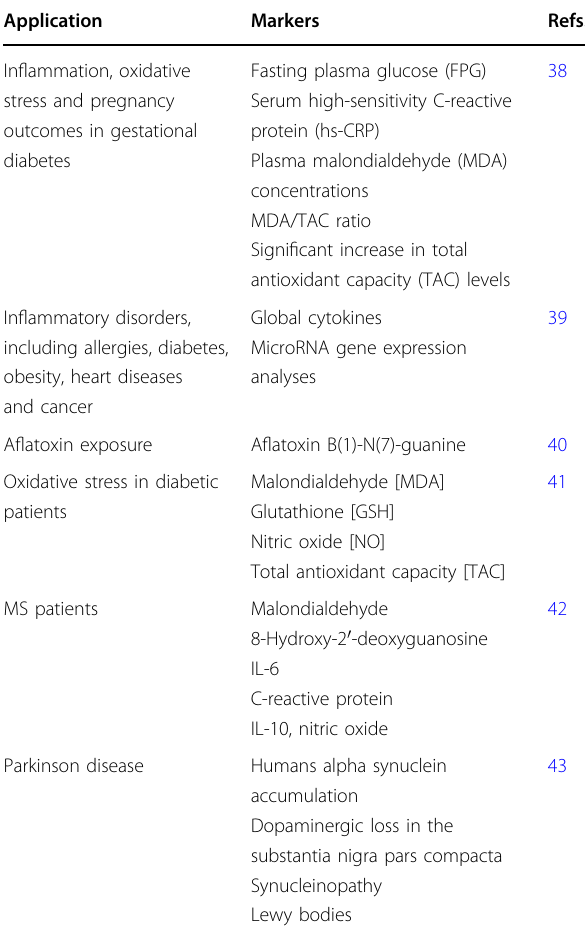
Table 2 Examples of biomarkers recently used in speci fi c disease